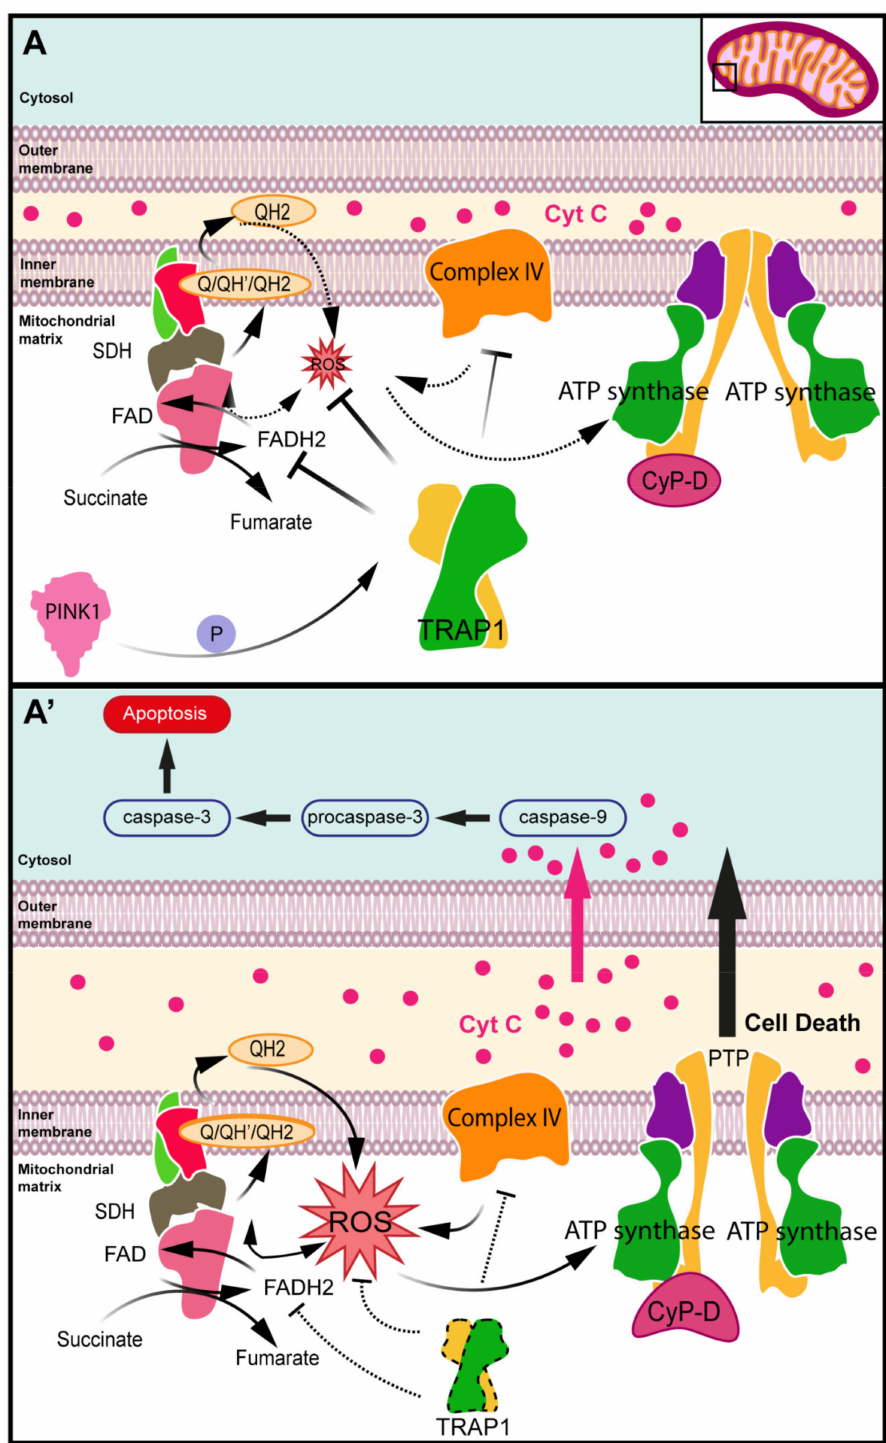
Figure 3. Role of TRAP1 in redox homeostasis. ( A ) TRAP1 inhibits reactive oxygen species (ROS) accumulation by controlling respiratory complexes of electron transport chain (ETC), namely, succinate dehydrogenase (SDH) and cytochrome oxidase. Through its interaction with cyclophilin D (CypD), TRAP1 inhibits mitochondrial permeability transition pore (mPTP) formation. Overexpression of TRAP1 blocks mitochondria-mediated apoptotic cascade and ensuing caspase-3 activation. ( A’ ) PTEN-induced kinase 1 (PINK1) depletion leads to cytochrome C (CytC) release, which correlates with reduction in TRAP1 phosphorylation by PINK1. Activated CypD sensitizes mPTP to opening, leading to mitochondrial swelling and depolarization, with outer membrane ruptures causing release of CytC into cytosol and eventually cell